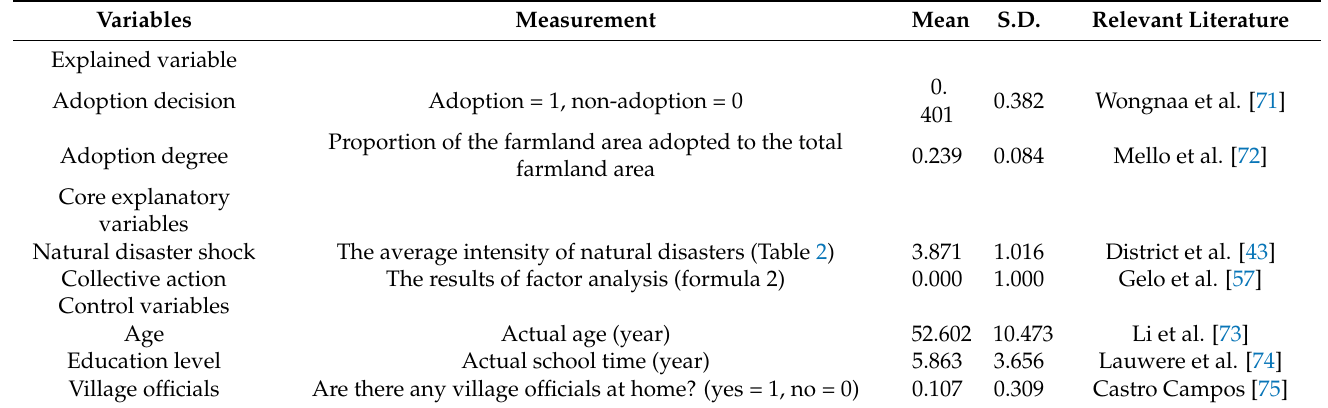
Table 4. Descriptive statistics of